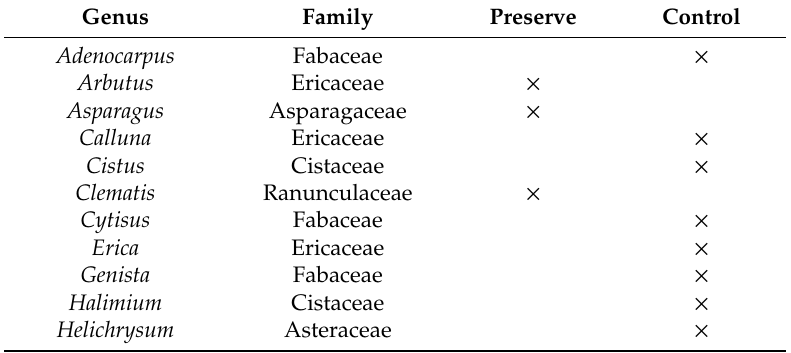
Table 2. Main native shrub genera to conserve and control in fuel management bands in